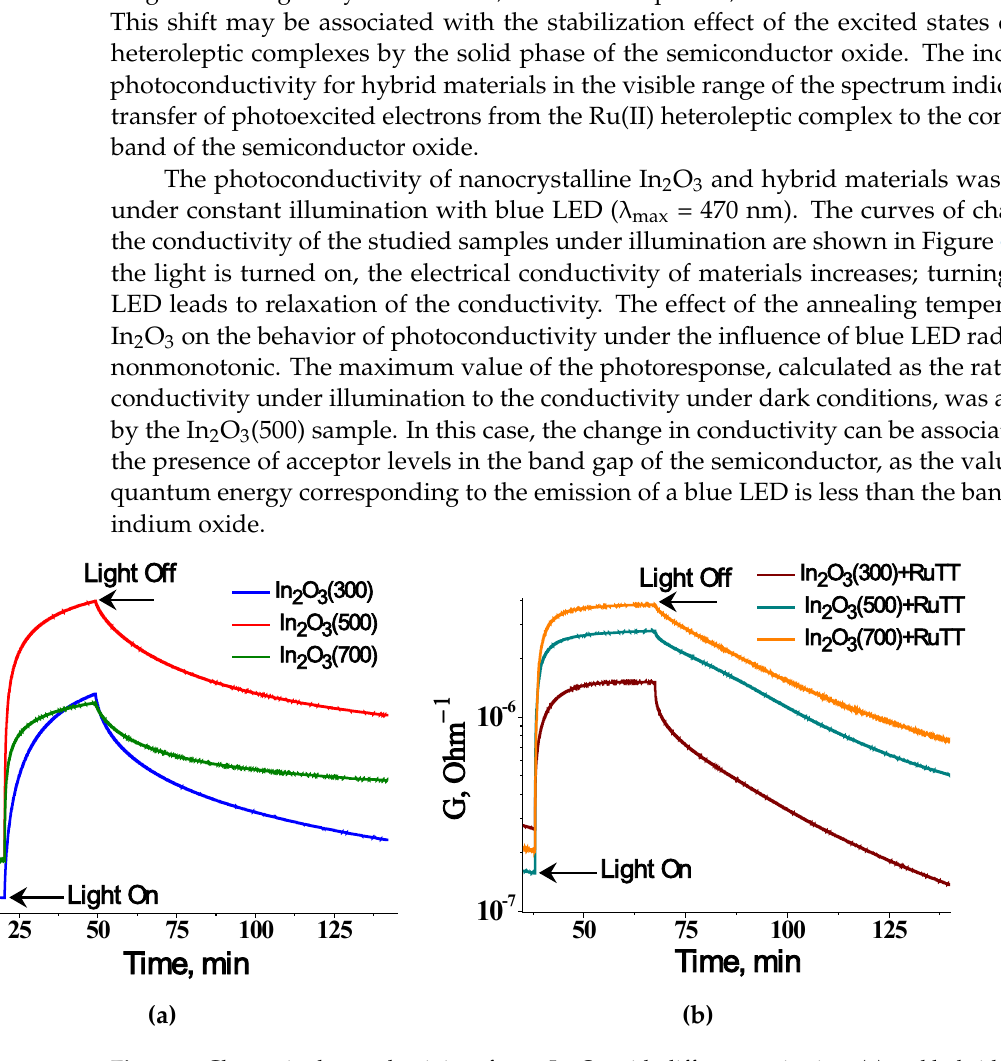
Figure 7. Photoresponse of synthesized samples.